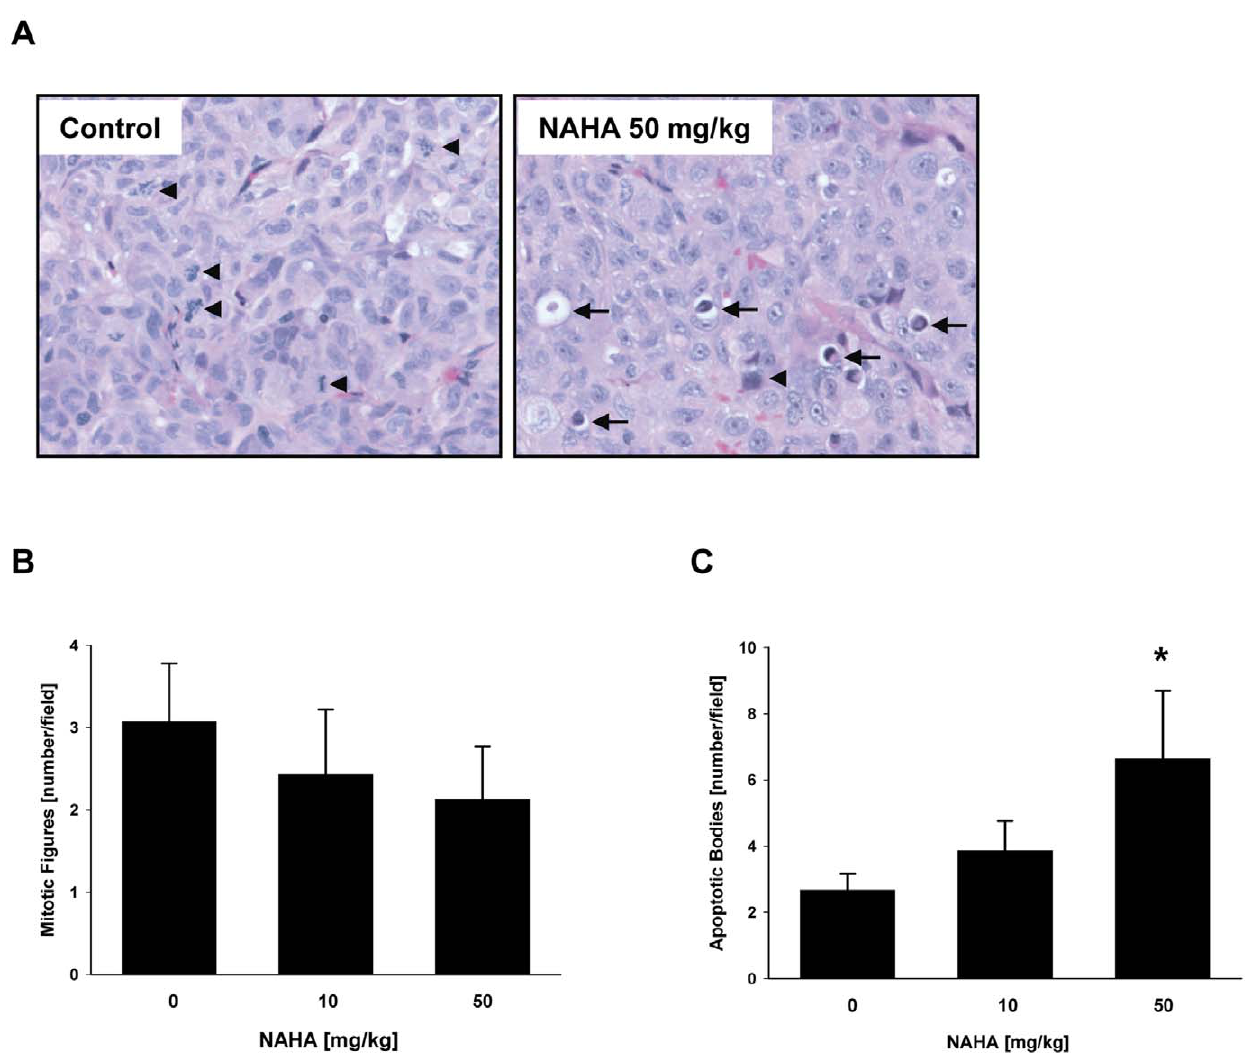
Figure 4. Histology of MDA-MB-231 xenografts. Tumors dissected from animals were sectioned and stained with (A) H&E, and (B) mitotic figures (arrowheads), and (C) apoptotic bodies (arrows) evaluated as described in Materials and Methods